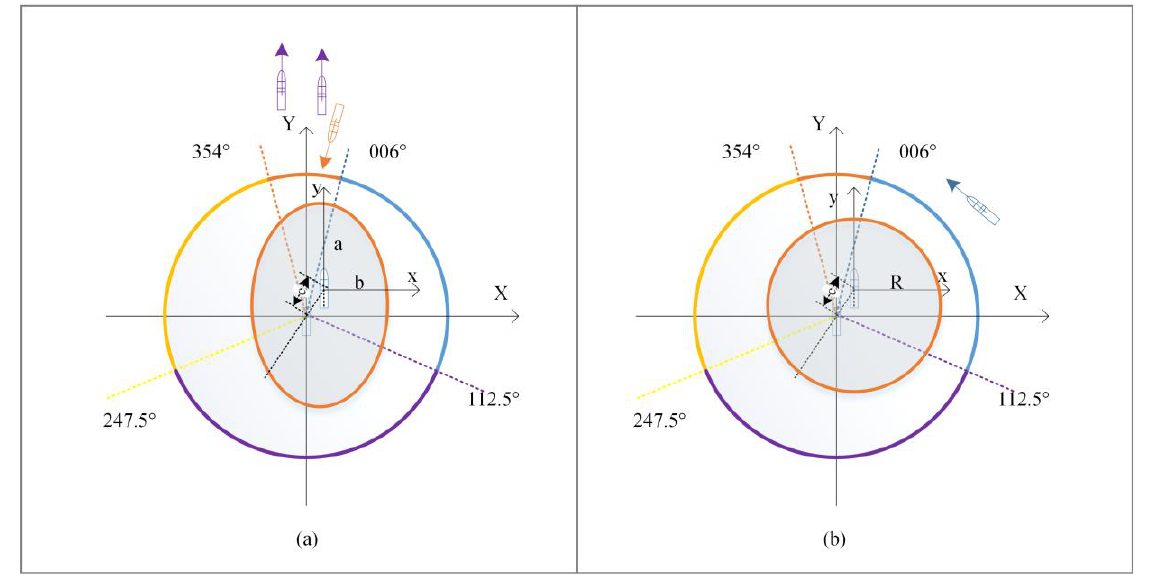
Figure 3. Ship domain model in different situations: ( a ) Head-on & overtaking situation; ( b ) cross situation.